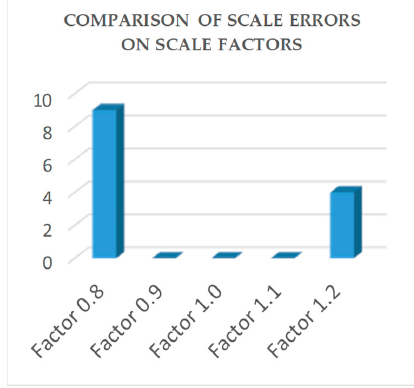
Figure 9. Comparison of the scale errors on 5 scale factors.